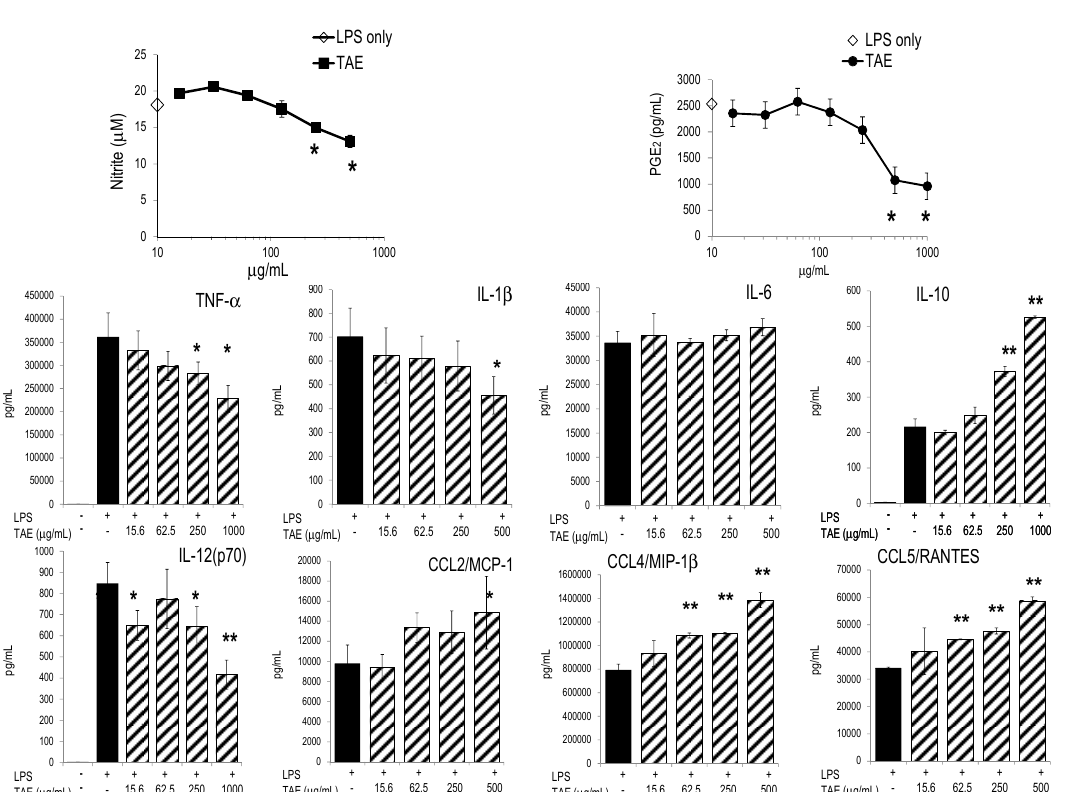
Figure 1. TAE inhibits the production of NO and PGE 2 and modulates cytokine and chemokine secretion in LPS-activated RAW264.7 cells. Cells were incubated with tomato aqueous extract (TAE), stimulated with 1 μ g/mL LPS and cultured for 24 h. “LPS only”: indicates the value obtained from LPS-stimulated cells (without substance) and is indicated on the y-axis. Representative results from one of three independent series are shown as mean (±SD) of duplicate. * p < 0.05, ** p > 0.01 ( vs. LPS-stimulated cells). Unstimulated cells produced 0.01 ˘ 0.00 µ M NO and 133 ˘ 18 pg/mL PGE 2 .